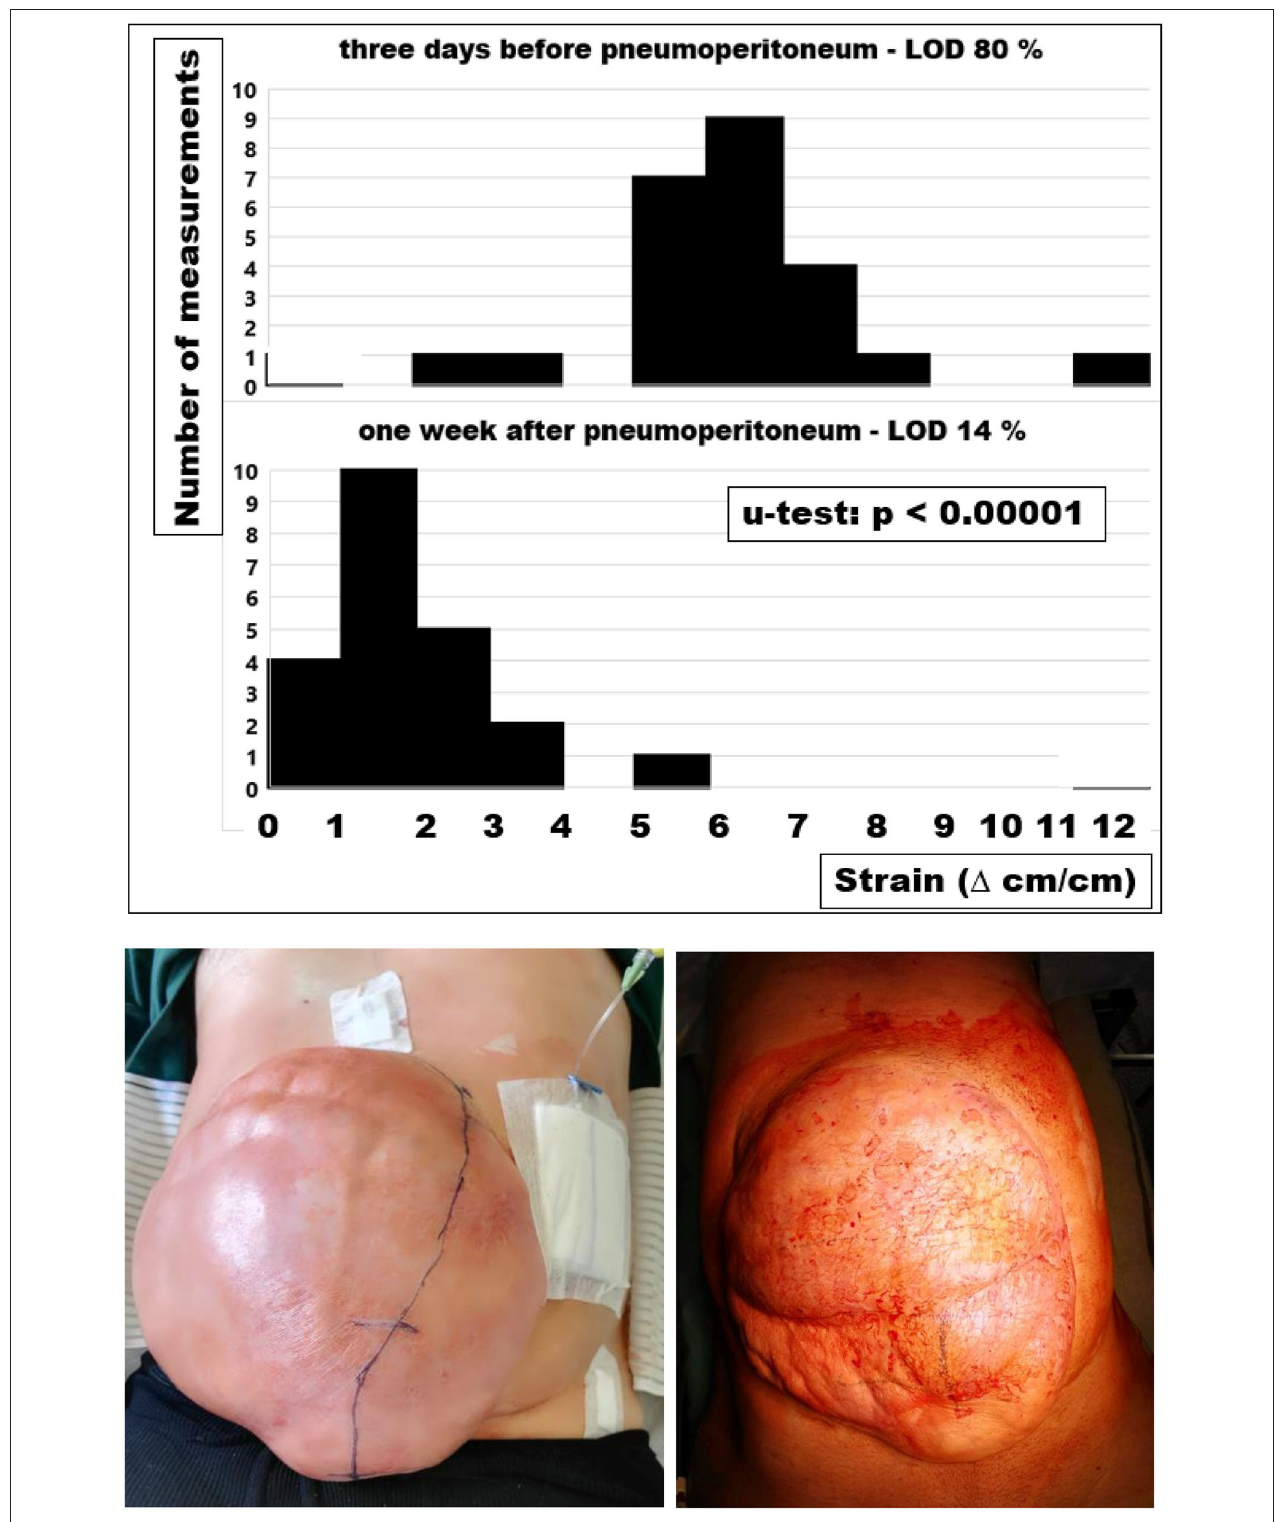
FIGURE 4 | Strain assessed as the regional shift of tissue taken from computed tomography of the abdomen at rest and during a Valsalva maneuver before and after a pneumoperitoneum (top and middle) and photos taken during the first filling of the pneumoperitoneum (bottom left) and before reconstruction of the abdominal wall (bottom right) . The pneumoperitoneum catheter was inserted under laparoscopic control and the incision line was free of adhesions marked under direct vision